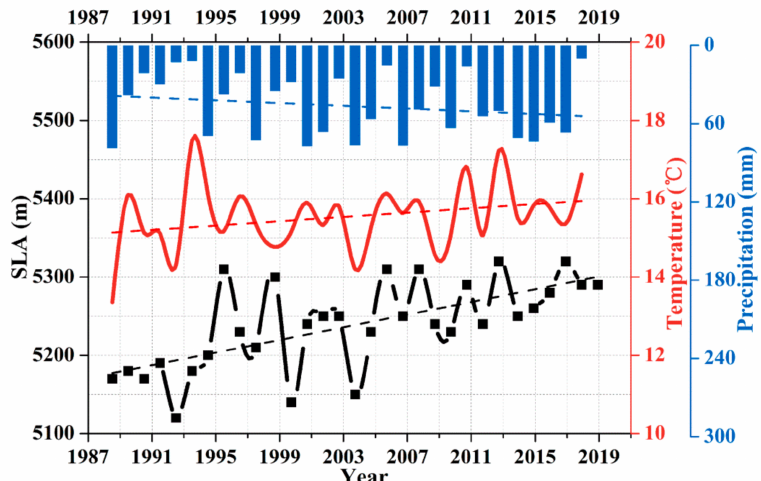
Figure 9. Summer precipitation (blue), summer mean temperature (red), and glacier SLA (black) across the Karakoram Mountains during the 1989–2019 period. Dashed lines indicate the best-fit linear trends for each